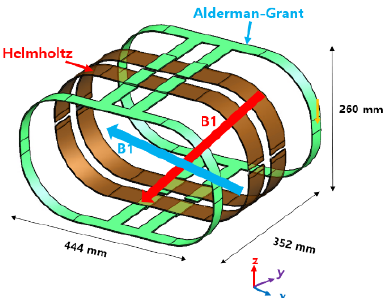
Figure 3. Geometry and dimensions of the numerically modeled body RF coil in a 0.3 Tesla open MRI system.